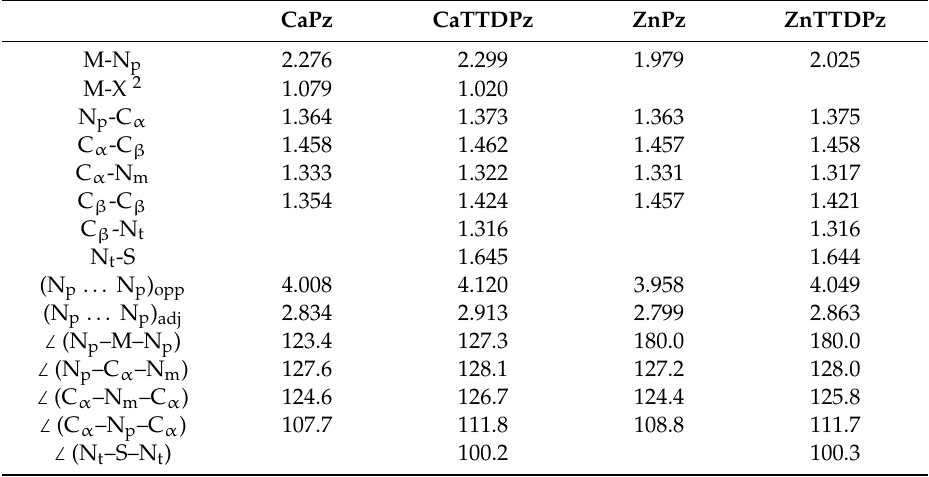
Table1. Molecularparameters 1 ofM-porphyzarine(MPz)andM-tetrakis(1,2,5-thiadiazole)porphyzarine (TTDPz) complexes optimized at B3LYP / pcseg-2 level.